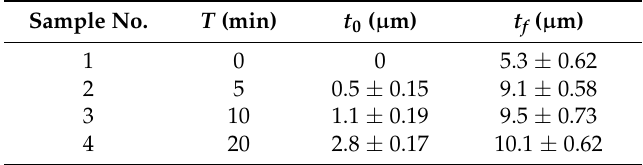
Table 1. The t 0 and t f for the thicknesses of the Ti transition layer and Ti-DLC (diamond-like carbon) coatings with various Ti transition layer deposition